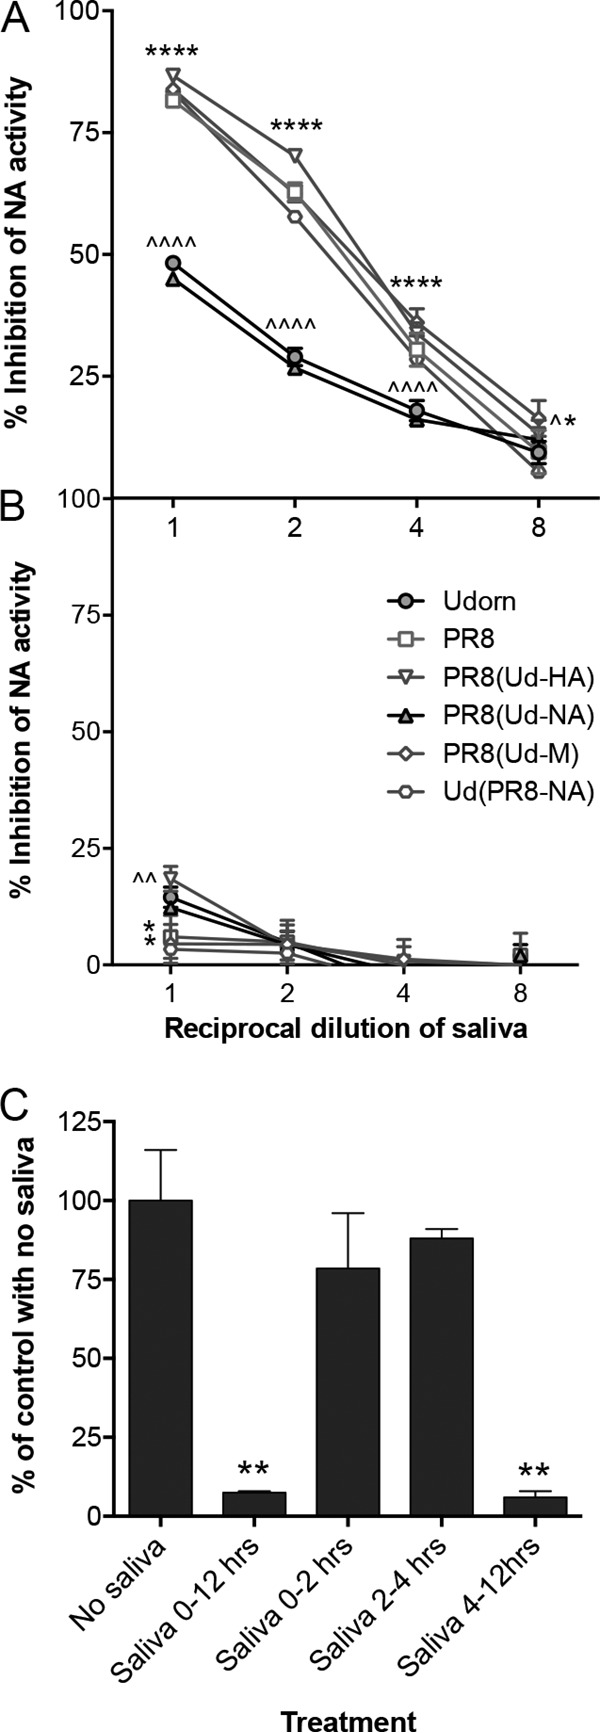
Inhibition of viral NA activity by untreated and RDE-treated saliva. (A and B) Standardized concentrations of reverse-engineered viruses were preincubated for 30 min at 37°C with serial 2-fold dilutions of either untreated (A) or RDE-treated (B) saliva, starting from a 9:1 (vol/vol) ratio of saliva to virus, followed by the addition of MUNANA substrate. The data show the percent inhibition of NA activity in the presence of saliva and are representative of the results of 2 individual experiments performed in duplicate. Filled symbols, viruses containing Udorn NA; open symbols, viruses containing PR8 NA. Compared to PR8, ^, P < 0.05 for PR8(Ud-M) at 1 in 8 dilution; ^^, P < 0.01 for PR8(Ud-HA) undiluted; and ^^^^, P < 0.0001 for Udorn and PR8(Ud-NA). Compared to Udorn, *, P < 0.05 for PR8(Ud-M) at 1 in 8 dilution (A), for PR8(Ud-M) undiluted (B), and for Ud(PR8-NA) undiluted (B); and ****, P < 0.0001 for PR8, PR8(Ud-HA), PR8(Ud-M), and Ud(PR8-NA). (C) PR8 virus was added to MDCK cell monolayers in TC96 wells at an MOI of 1 (105 PFU), allowed to adsorb for 1 h at 37°C, and then removed by washing. Saliva at a 1 in 2 dilution was added and remained on the monolayers throughout the infection (0 to 12 h), was added and remained on the monolayers for the first 2 h followed by thorough washing and replacement with medium without saliva (0 to 2 h), was added after 2 h for an additional 2 h (2 to 4 h), or was added after 4 h for the remainder of the infection cycle (4 to 12 h). At 12 h postinfection, the supernatants were sampled, and the amount of infectious virus was determined by plaque formation in MDCK cells. The data are expressed as the percentages of virus from cultures containing no saliva, which had an infectious-virus yield of 106.47 ± 0.07 PFU. The error bars represent the range of duplicate samples. **, P < 0.01 compared to no-saliva control.